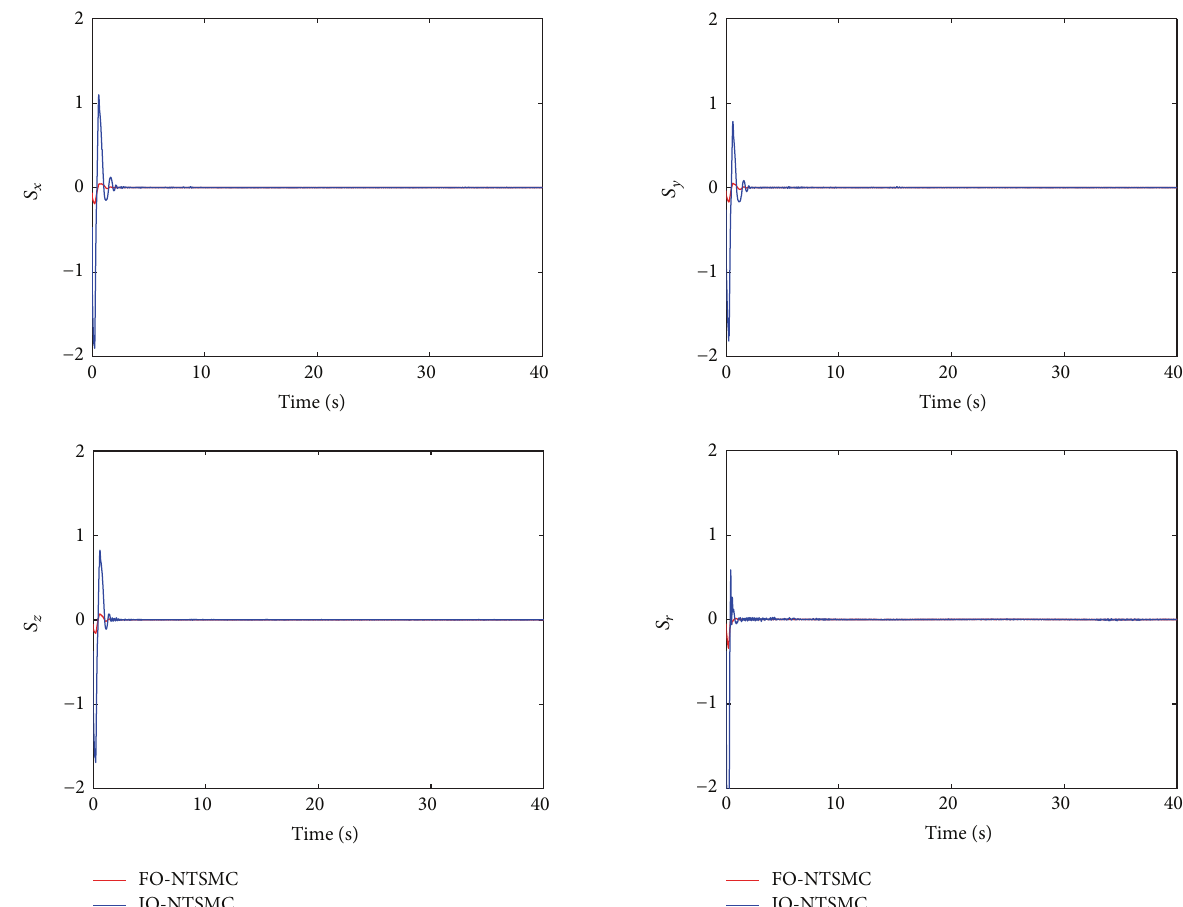
Figure 7: Sliding manifold of output feedback FO-NTSMC and